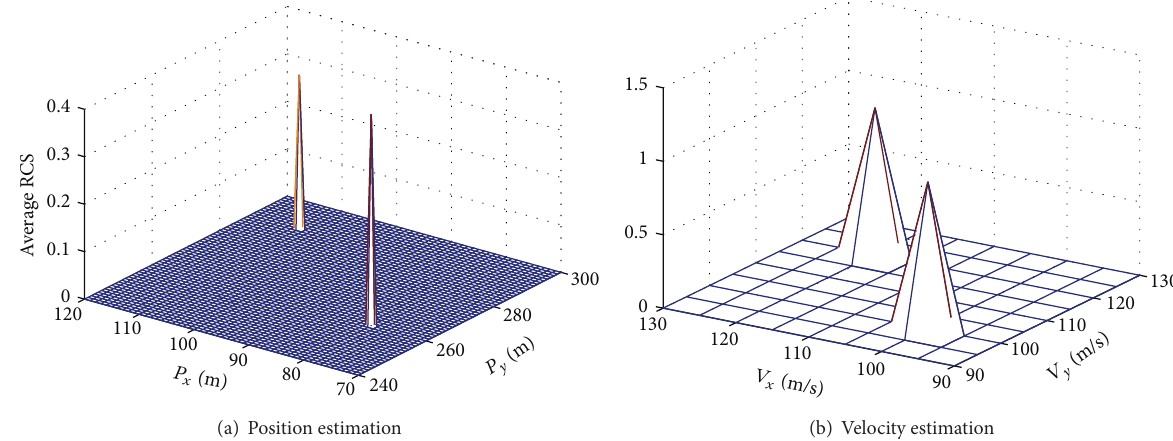
Figure 3: Targets’ parameters estimation using JOMP.